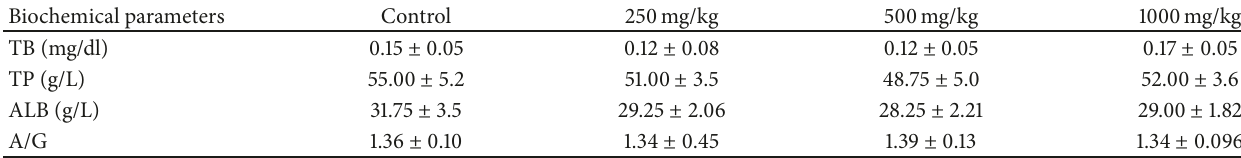
Table 5: The effects of different concentrations of pomelo methanolic extracts on serum liver markers.